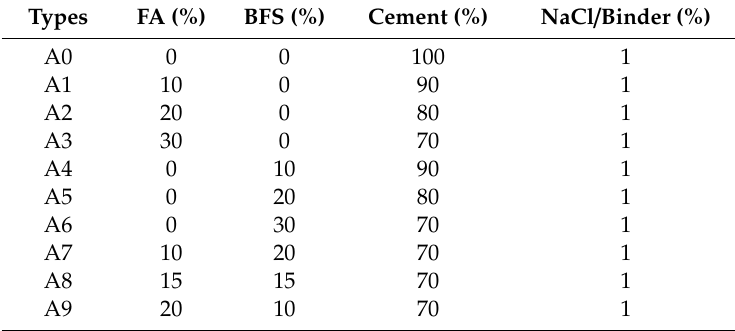
Table 3. Mix proportions of cement